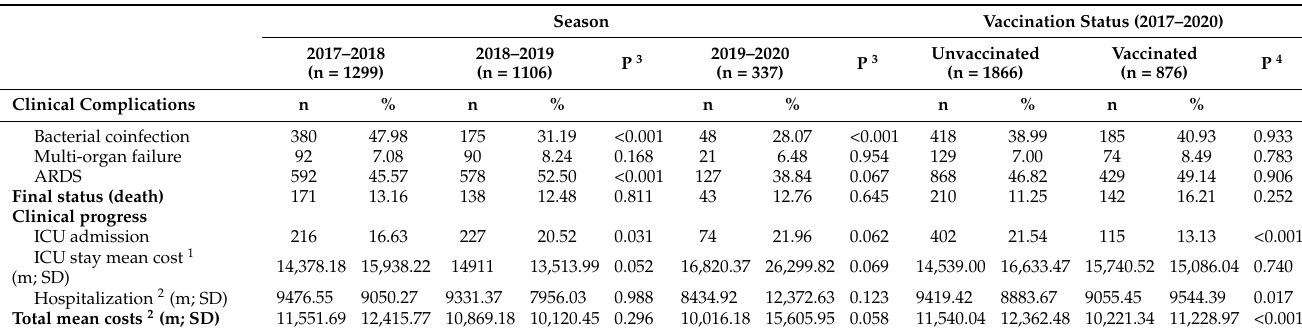
Table 5. Clinical complications and economic costs in vaccinated and unvaccinated cases by season and